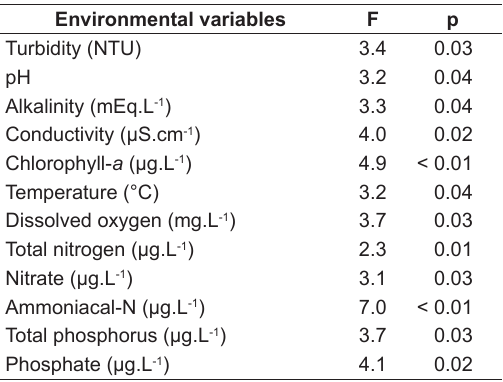
Table 4. The ANOVA results of the environmental variables in the studied